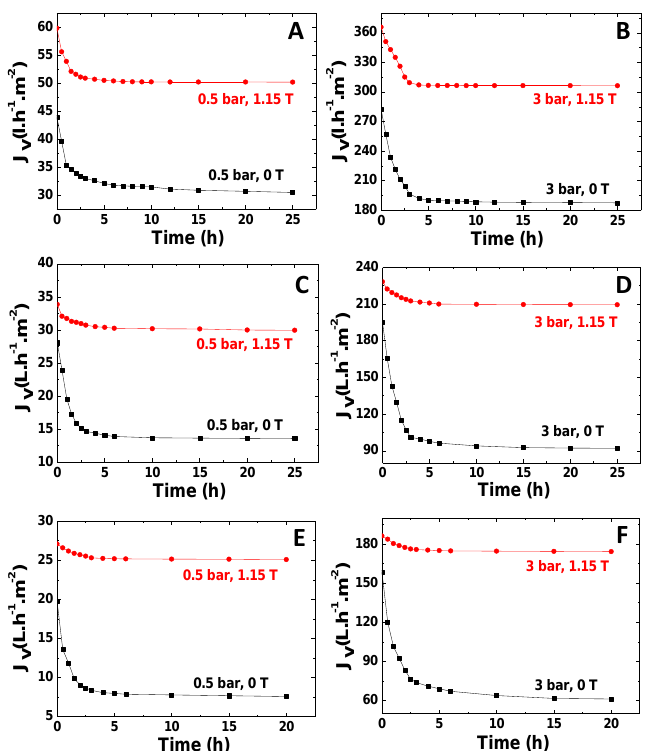
Figure 2. Variation of the permeate flux over time obtained during the permeation of a 0.5g/L bovine serum albumin (BSA) solution (pH 7.1) at transmembrane pressures (TMP) of 0.5 bar and 3 bar with magnetic strength of 0 T and 1.15 T, at T = 298 K, through ( A and B ) membranes made out of spheres prepared by the polymerization-induced self-assembly (PISA) strategy. ( C and D ) Membranes obtained from the nonsolvent-induced phase separation (NIPS) procedure containing PMAA 47 -coated nanoparticles (NPs), and ( E and F ) membranes obtained from the NIPS procedure containing DMSA-coated NPs.